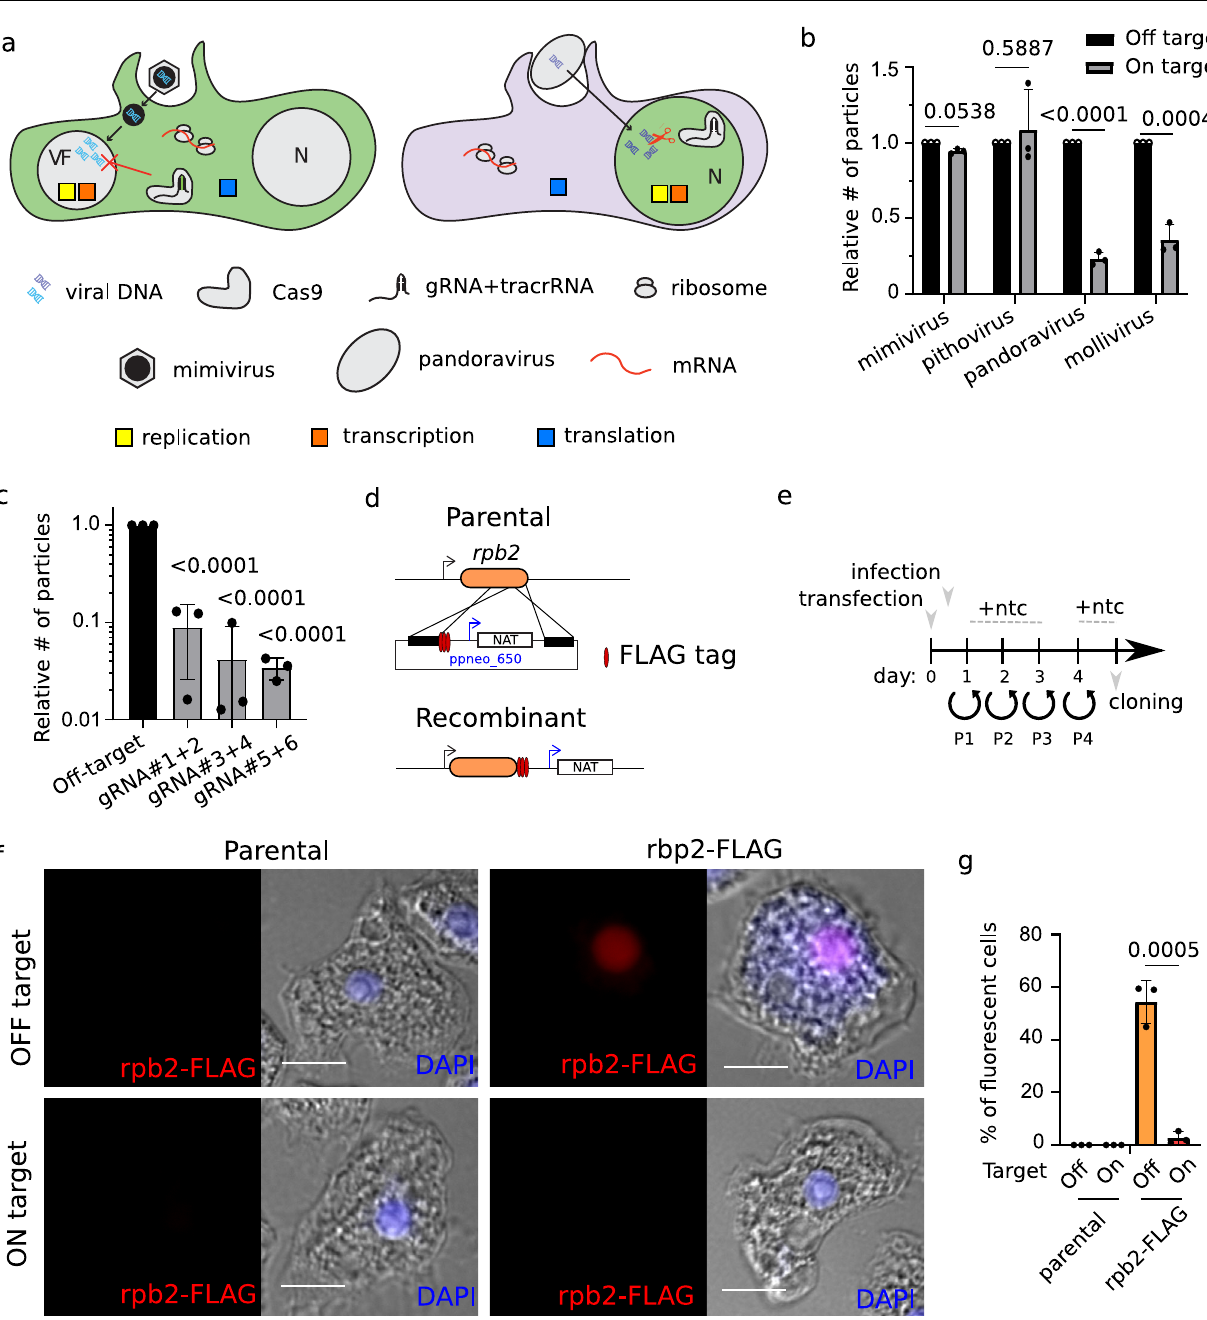
were performedasFig. 2b. Guides targeting mollivirus mcp were usedasoff-target gRNAs. Sequence of the gRNA 1 to 6 are shown in Table S1. The null hypothesis ( α = 0.05) was tested using unpaired two-tailed Student ’ s t tests. d Schematic representation of the vector and strategy utilized for rbp2 endogenous tagging in Pandoravirus neocaledonia . Selection cassette was introduced by homologous recombination. e Cartoon depicting the strategy for selection of recombinant viruses. Viral infection was performed 1h post-transfection. Ntc: Nourseothricin. immuno fl uorescence signal disappears upon infection of cells encoding CRISPR/ The mean±SD of at least 200 amoebas (3 independent experiments ( n =3)) is shown. The null hypothesis ( α = 0.05) was tested using unpaired two-tailed Stu- dent ’ s t tests. Source data are provided as a Source Data fi